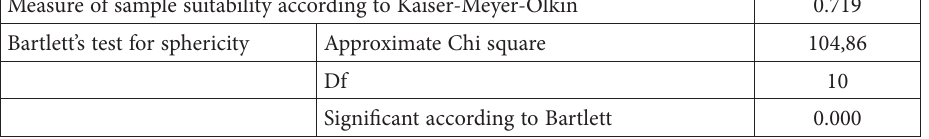
Table 3. KMO and Bartlett test Measure of sample suitability according to Kaiser-Meyer-Olkin 0.719 Bartlett’s test for